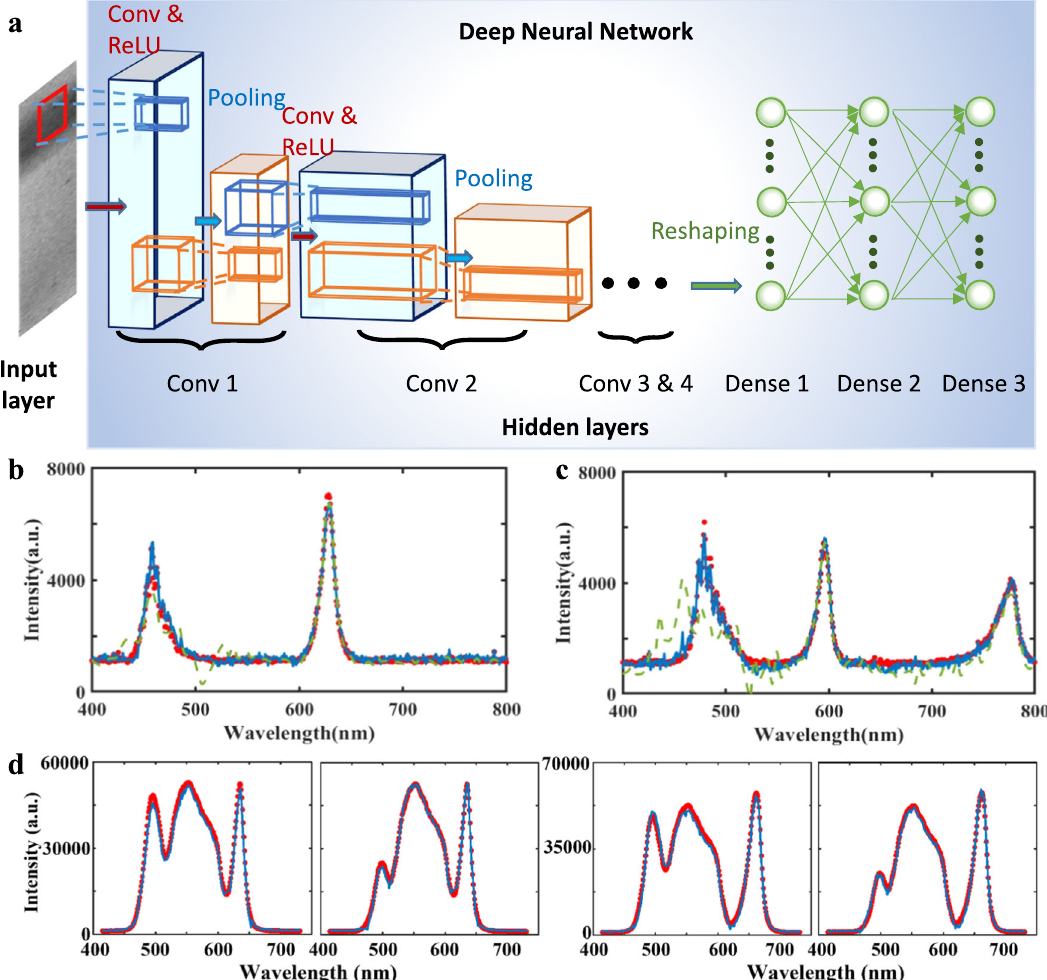
Fig.2|DL-basedreconstruction.a Thearchitectureofthedeep-learningnetwork. Forthecaseof b two-peakand c three-peakwavelengthcombinations,comparison of deep-learning-reconstructed spectrum (solid blue line), spectrum calculated using conventional method (dashed green line), and the gold standard spectrum